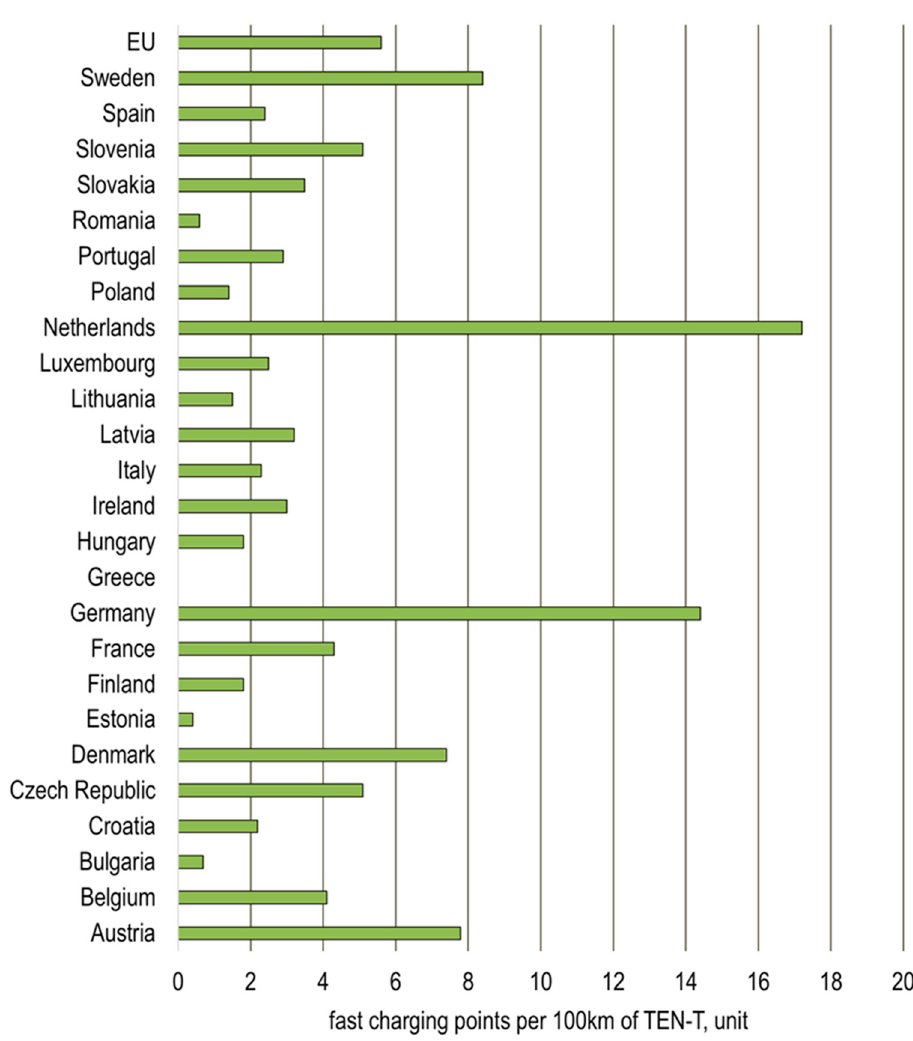
Figure 6. Number of fast combined charging system (CCS) chargers for every 100 km of TEN-T network in EU in 2020, by country.